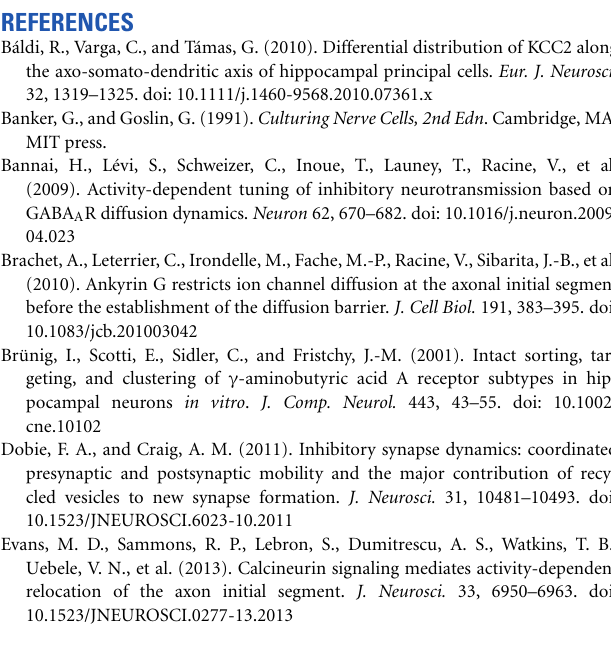
Supplementary Figure 4 | (A) As Figure 1C . Subcompartments delineated from neurofascin staining overlaid with α 1-QD trajectories. (B) As (A) , for KCl-treated neuron. (C,D) Instantaneous α 1-GABA A R diffusion coefficient in control (black) and KCl conditions (gray, dashed) in AIS (C) and dendrites (D) . Control, 45 cells; KCl, 47 cells; 5 experiments. In the AIS, median D increased 1.2-fold, n control = 10 , 099, n KCl = 18 , 933, p < 2 × 10 − 16 ; in dendrites, lateral mobility was unaffected, n control = 137 , 377, n KCl = 175 , 592, p > 0 .